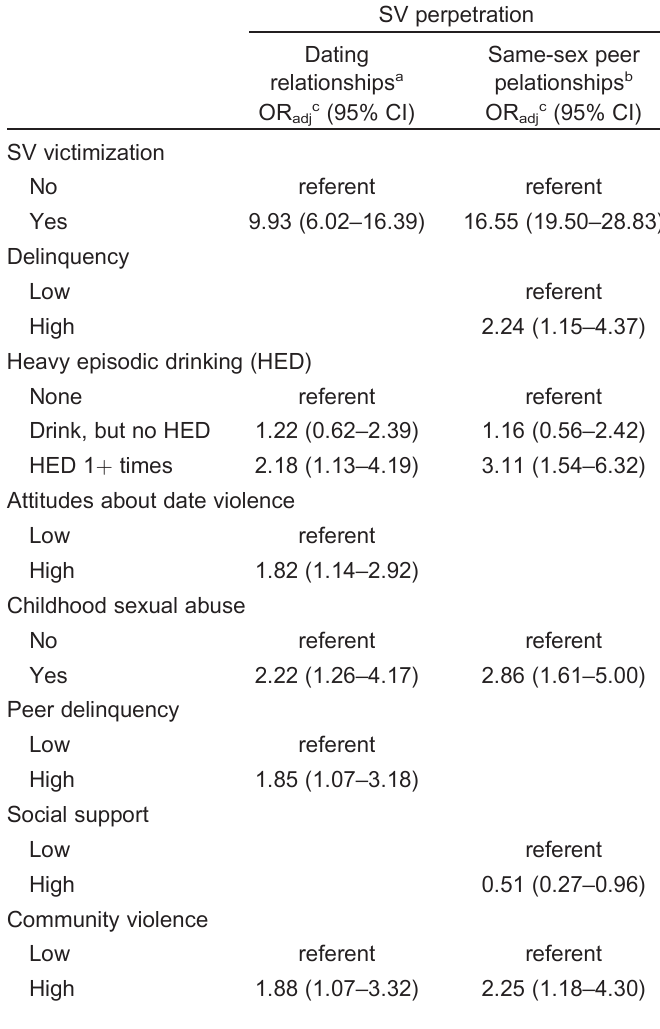
Table 2. Multivariable logistic regression analyses of the associations between risk and protective factors and sexual violence (SV) perpetration across dating and same-sex peer relationships among high risk youth in grades, 7, 9, 11, and